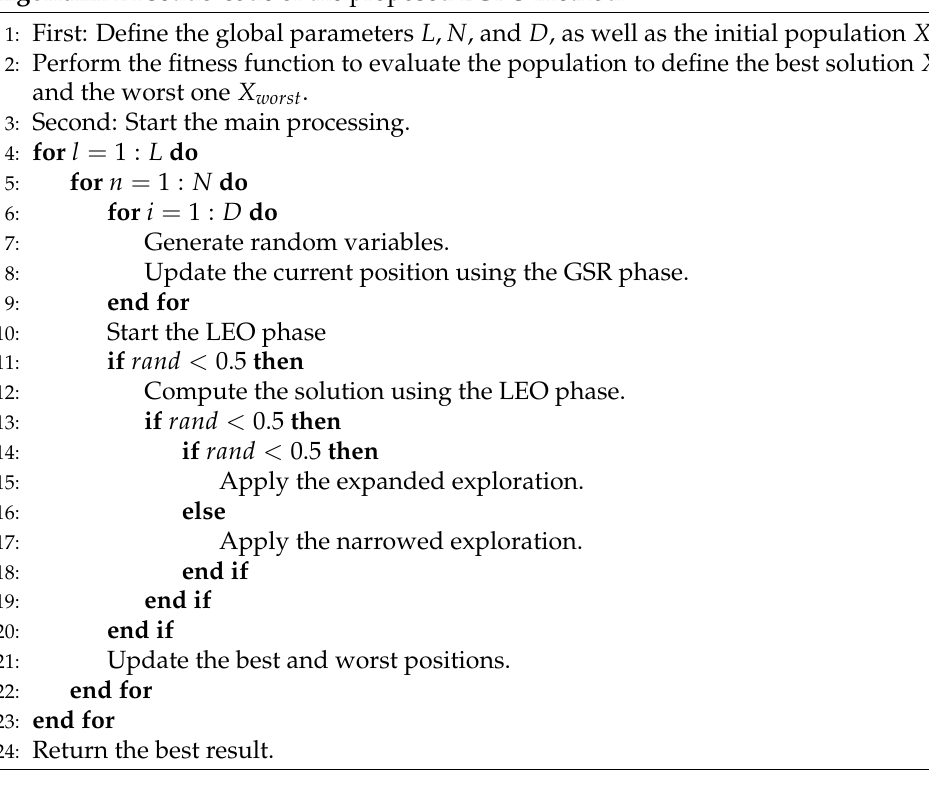
Algorithm 2 Pseudo-code of the proposed EGBO